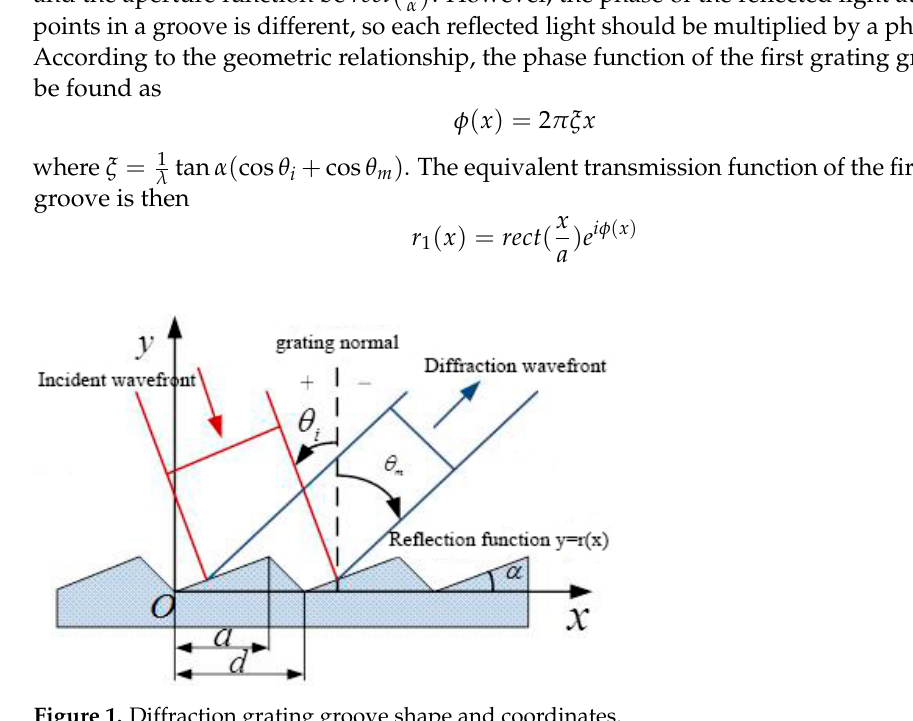
Figure 1. Diffraction grating groove shape and coordinates.